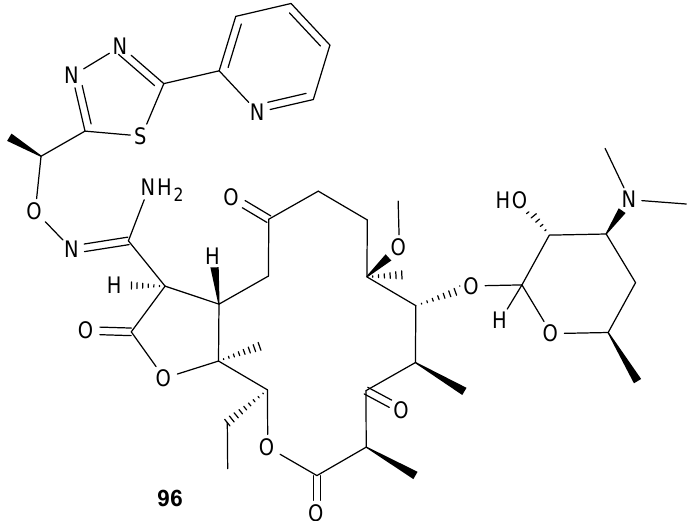
Figure 14. Nafithromycin (WCK 4873) ( 96 ).